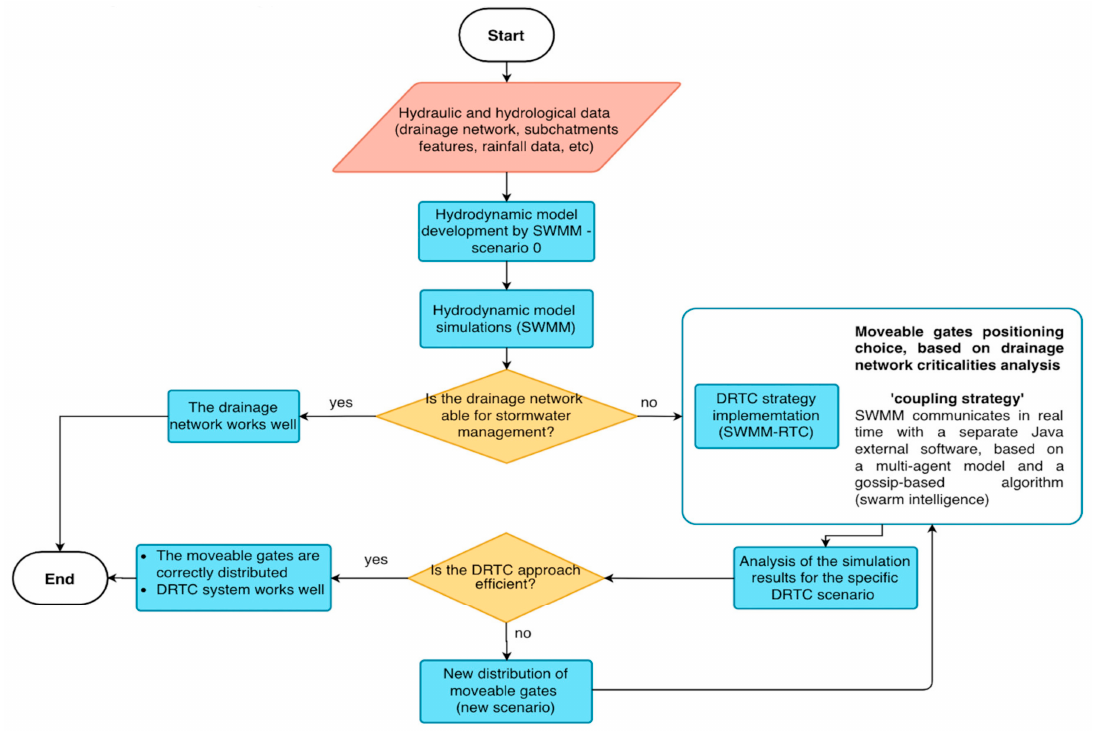
Figure 1. The flowchart of the methodology.